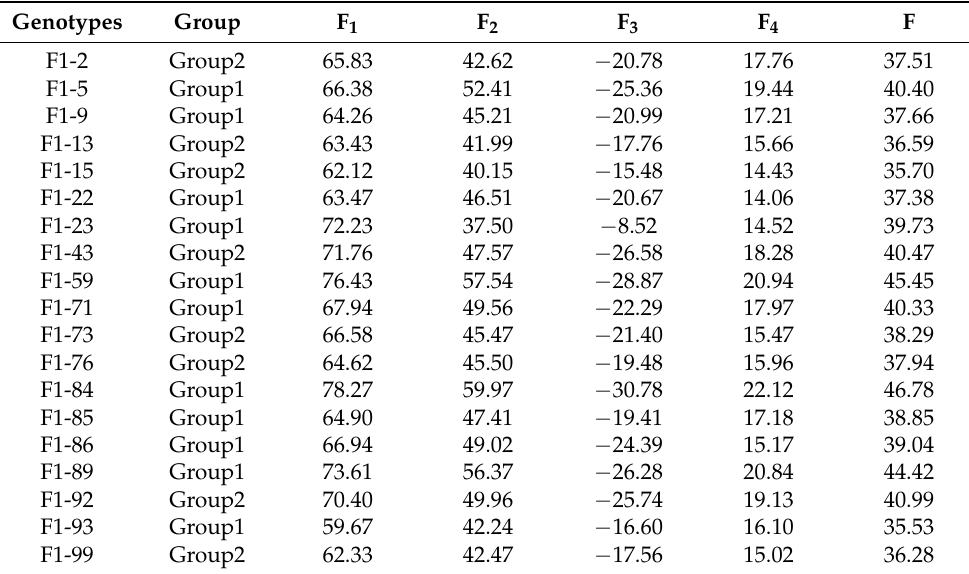
Table 4. Linear-regression analysis between sucrose yield and six related traits.